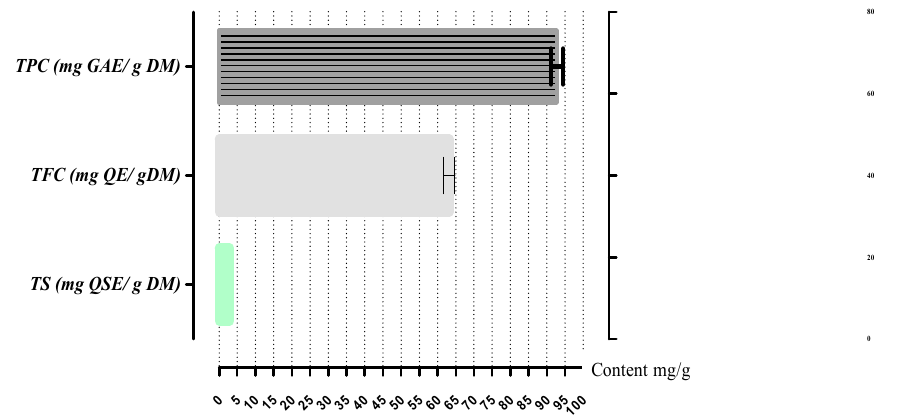
Figure 1. Total bioactive compounds of A. gombiformis extract. Bars represent standard deviation.